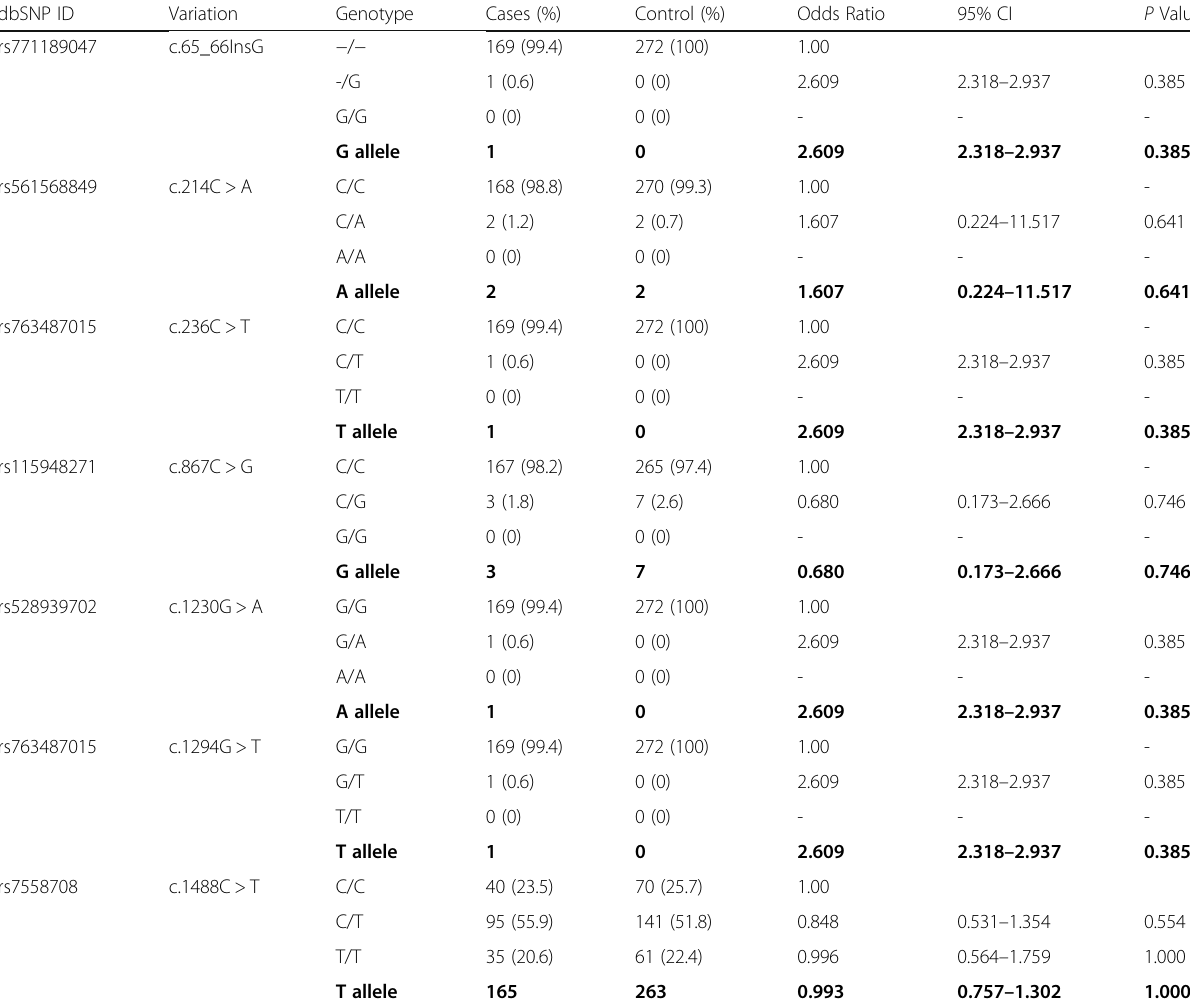
Table 3 Genotypes and allele distributions of EGR4